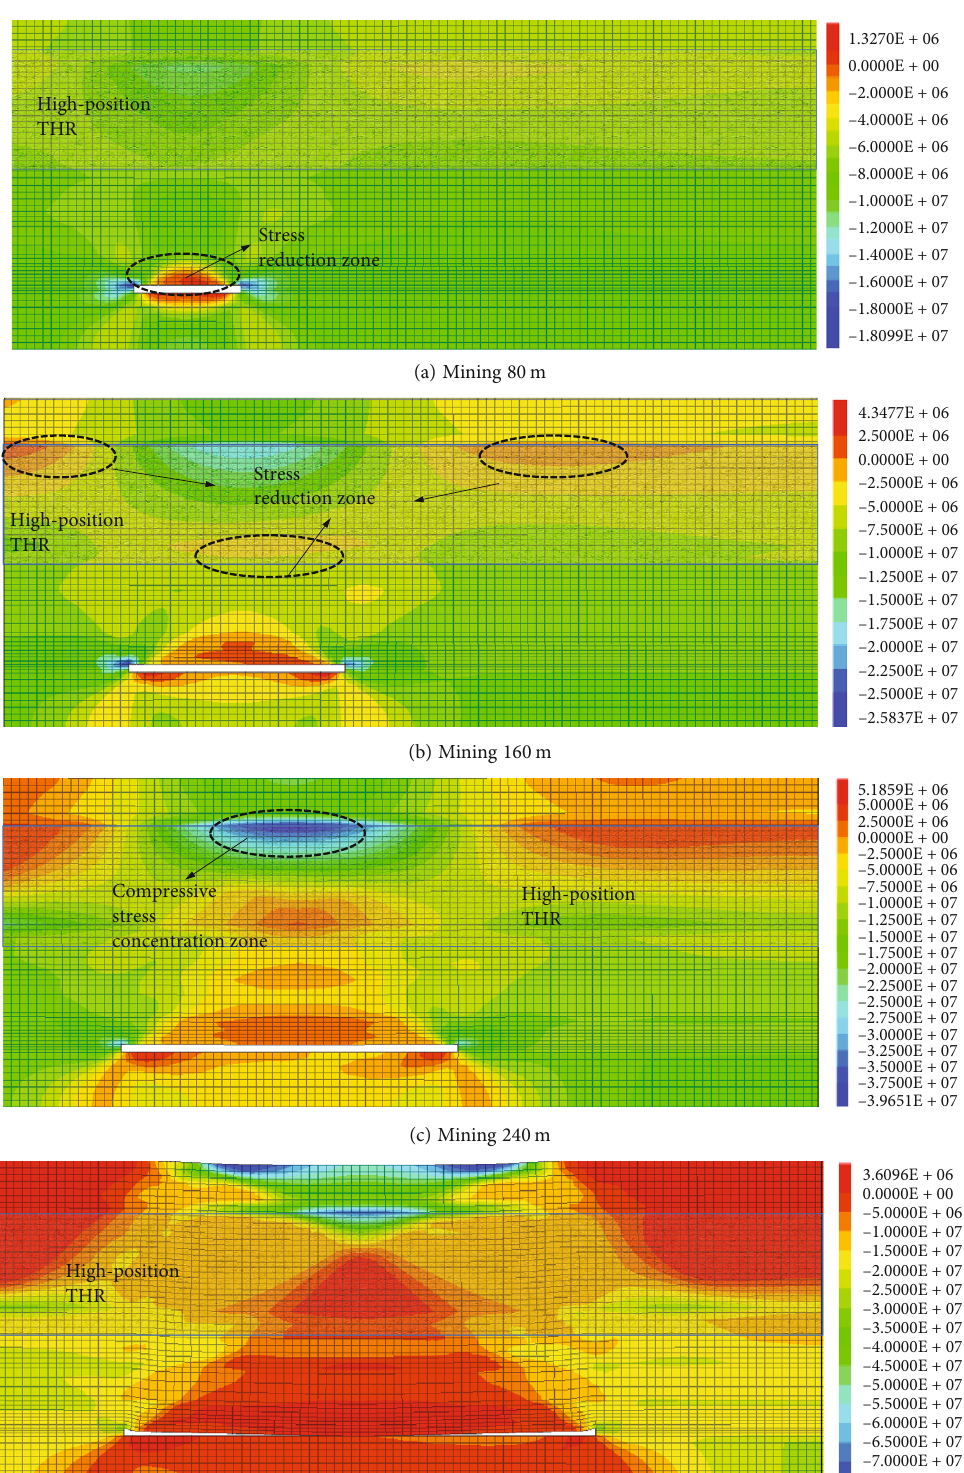
Figure 13: The horizontal stress distribution under di ff erent excavation